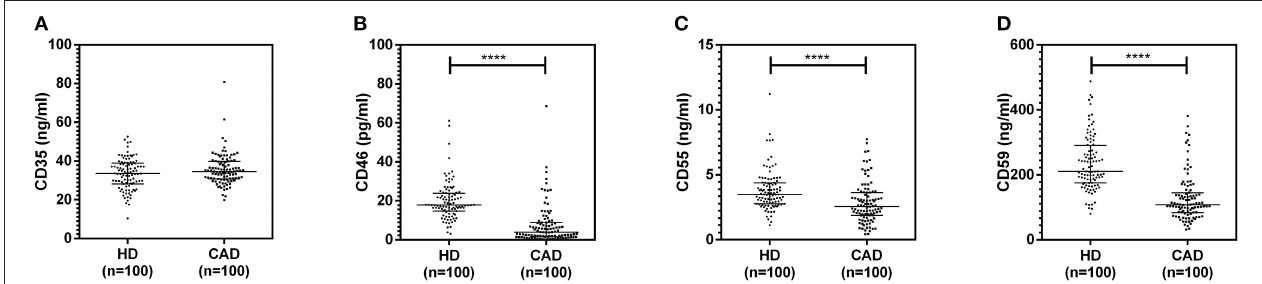
FIGURE 4 | Plasma levels of soluble forms of complement regulatory proteins in CAD patients. Soluble forms of CD35, CD46, CD55, and CD59 in the plasma were measured by sandwich ELISA (A–D) . Plasma levels of CD46, CD55, and CD59 were significantly lower in CAD patients compared to healthy donors. Mann-Whitney U test was used for comparison of values between groups. Four asterisks (****) indicate a p -value of < 0.001.